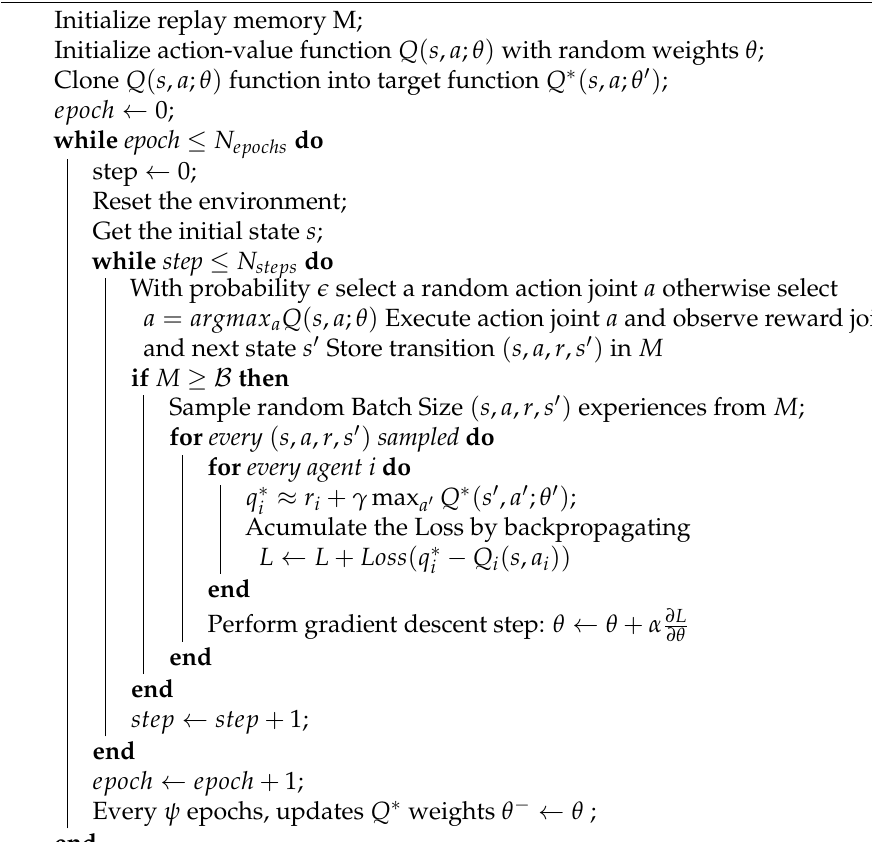
Algorithm 2: DDQL with centralized learning.